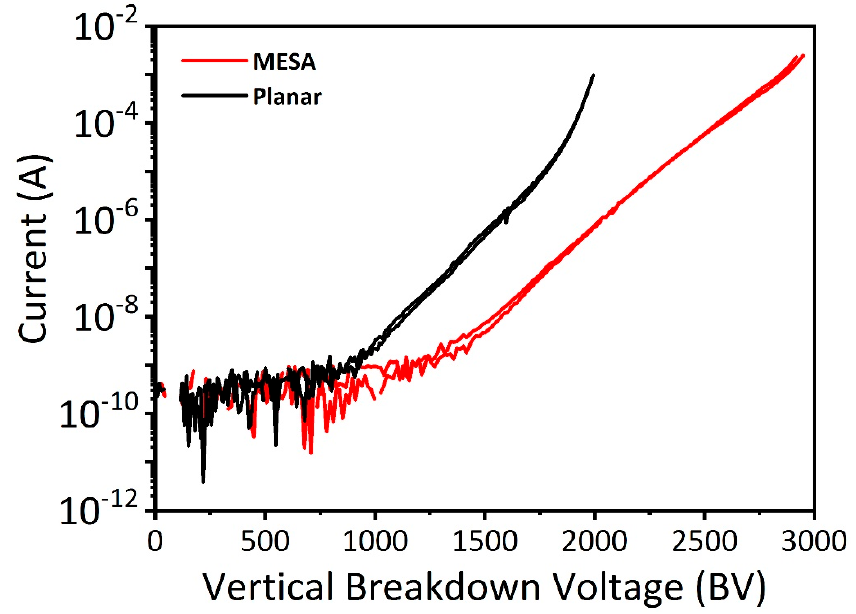
Figure 5. Reverse breakdown voltage measurement results of GaN p - i - n diodes with (red line) and without (black line) the mesa structure. The BV was defined as 4 mA. Each type of GaN p - i - n diode shows two I-V curves from two different diodes, respectively.